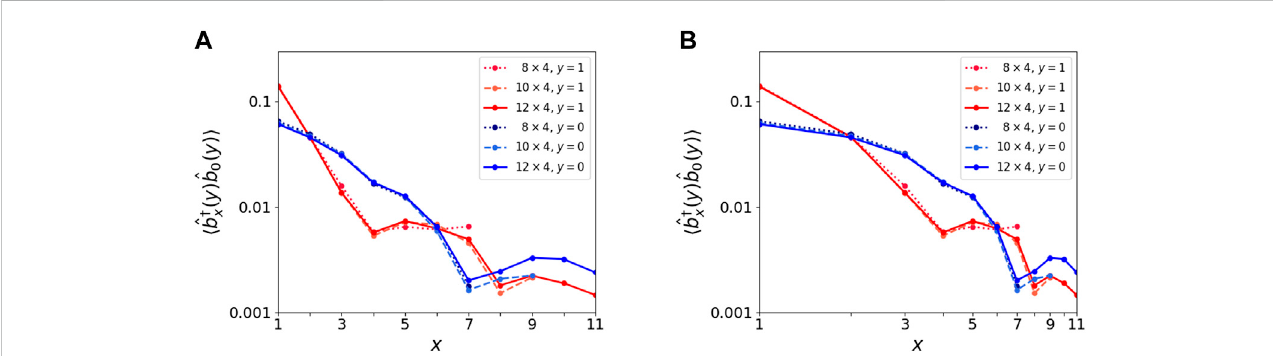
FIGURE 3 Two-point correlation function for the ρ = 1/8 state using open boundary conditions in the (A) log-linear scale and (B) log-log scale. Different shades of colors red and blue correspond to the row in the bulk ( y = 1) and at the edge ( y = 0). Dotted, dashed, and solid lines correspond to system sizes 8 × 4, 10 × 4, and 12 × 4, respectively.